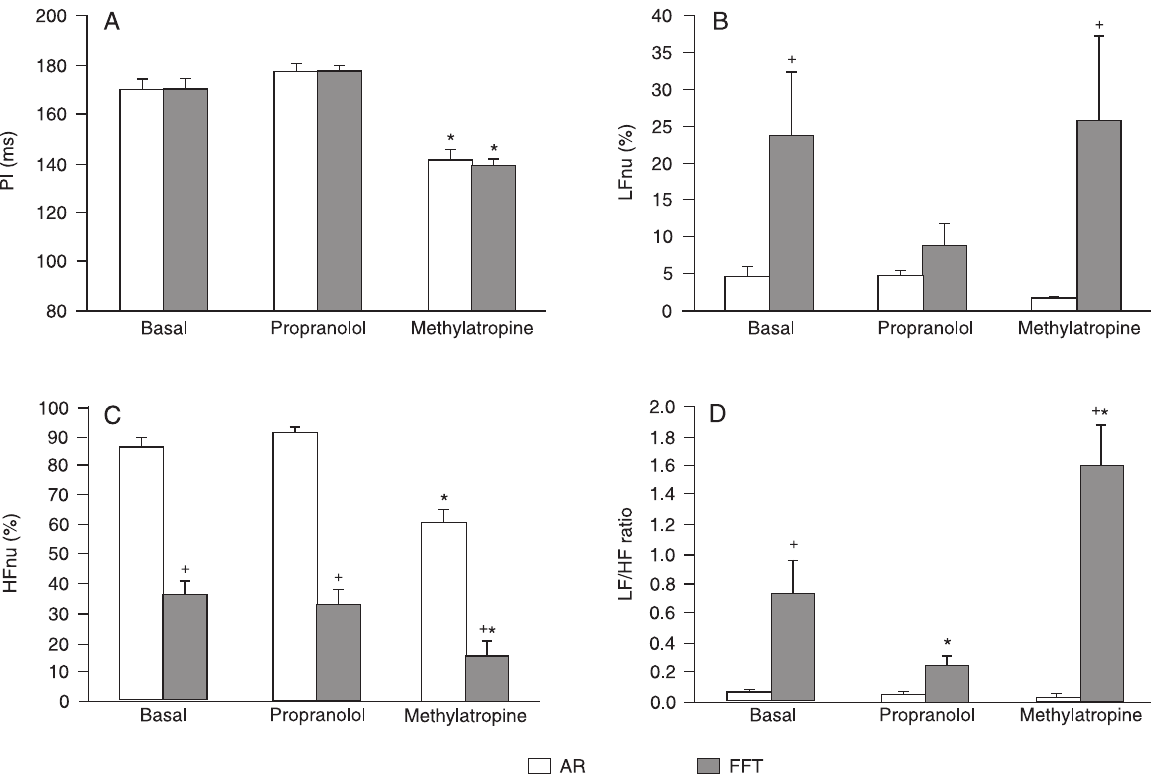
Figure 2. Mean pulse interval (PI, Panel A) and LFnu (Panel B) and HFnu (Panel C) oscillations, and LF/HF ratio (Panel D) for PI at basal condition and after pharmacological blockade of sympathetic (propranolol) and parasympathetic (methylatropine) systems in rats. LF = low-frequency; HF = high-frequency; LFnu = normalized power of LF; HFnu = normalized power of HF; AR = autoregressive method; FFT = fast Fourier transform method. *P ≤ 0.05, compared to respective basal condition. + P ≤ 0.05, FFT compared to